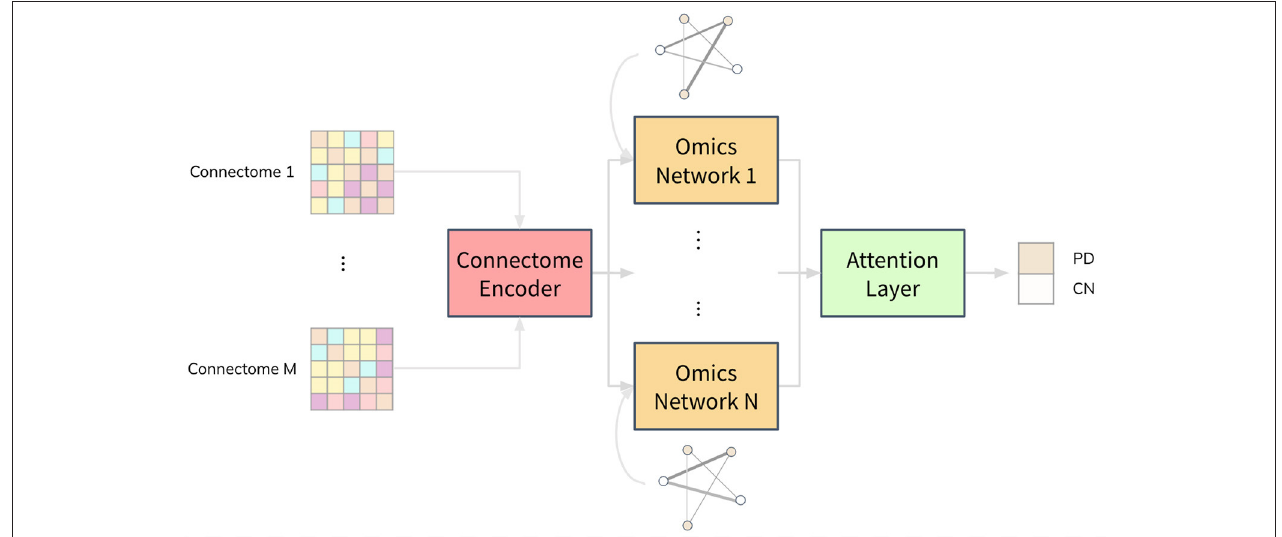
FIGURE 1 | Illustration of the JOIN-GCLA architecture. It is made up of 3 parts: a connectome encoder, omics networks and an attention layer. The connectome encoder receives connectome features from neuroimaging modalities, omics networks embed omics data in their graphs, and the attention layer consolidates all the outputs of the omics networks to make a single final